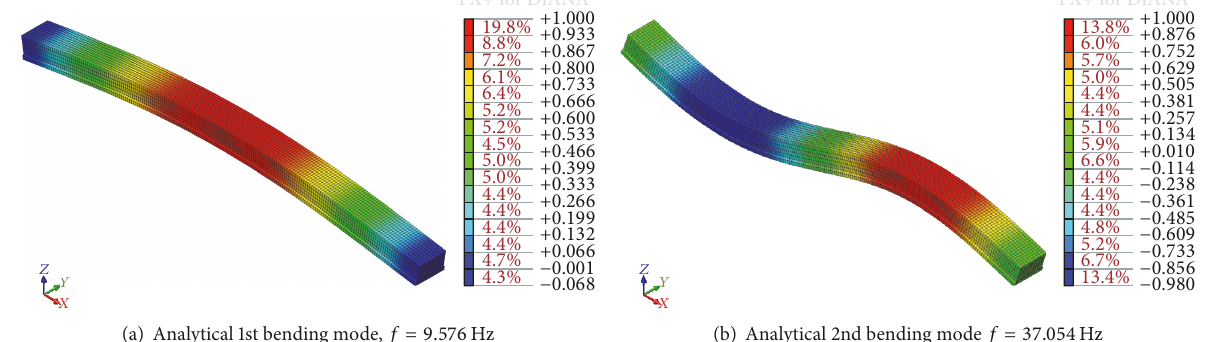
Figure 23: ((a)-(b)) Analysis results of natural frequencies of girder No. 3 in May 2015.